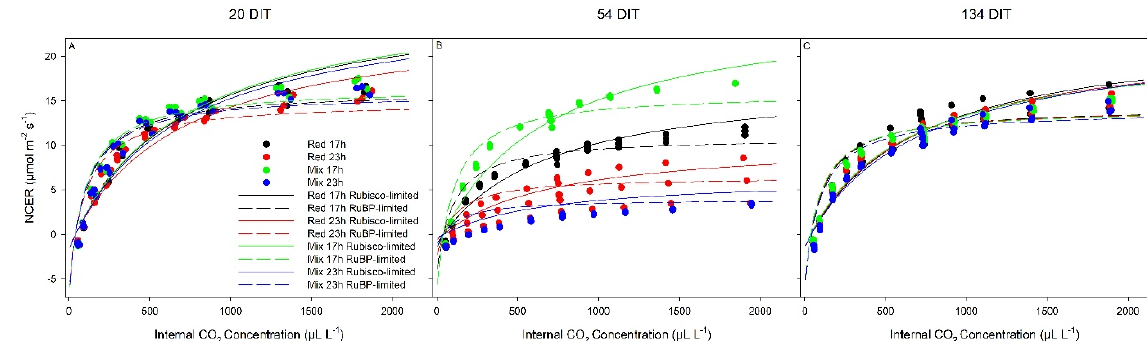
Figure 7. Photosynthetic CO 2 response curve from leaves grown under red 17 h, red 23 h, mix 17 h, and mix 23 h lighting treatments at 20 DIT (December 5, 2018, panel A ), 54 DIT (January 8, 2019, panel B ), and 134 DIT (March 29, 2019, panel C ). As determined using a Li-COR 6400 with a red/blue standard Li-COR light source. Measurements were performed at 300 µmol m − 2 s − 1 PAR, a temperature of 24 °C, and relative humidity of 55–65%. Rubisco- and RuBP-limited fit lines were determined using temperature corrections from [31,32]. Table 3. Summary of the major physiological traits as determined by leaf CO 2 response curves (Figure 7) from tomatoes grown under red 17 h, red 23 h, mix 17 h, and mix 23 h at 20 (December 5, 2018), 54 (January 8, 2019), and 134 DIT (Mar. 29, 2019). The maximum rate of Rubisco carboxylation (V cmax ) and the maximum rate of electron transport (J max ) were determined using equations from [31,32]. Pn max was calculated from y = y o + a(1 − e ( − b*x) ) and indicates the maximum rate of photosynthesis at a light level of 300 µmol m -2 s -1 at a saturating CO 2 level. Values ± the standard error of the mean are representative of n = 3. Within each parameter and time of measurement, letter groups (A, B, C) represent a statistical difference as determined by a two-way ANOVA with a Tukey–Kramer adjustment ( p < 0.05).